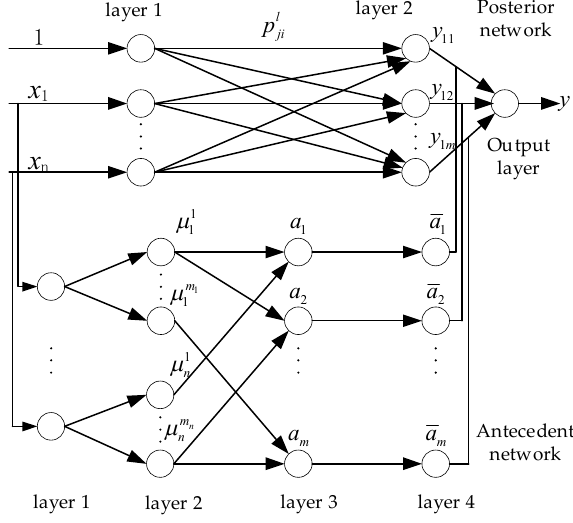
Figure 9. T-S Fuzzy neural network structure diagram.